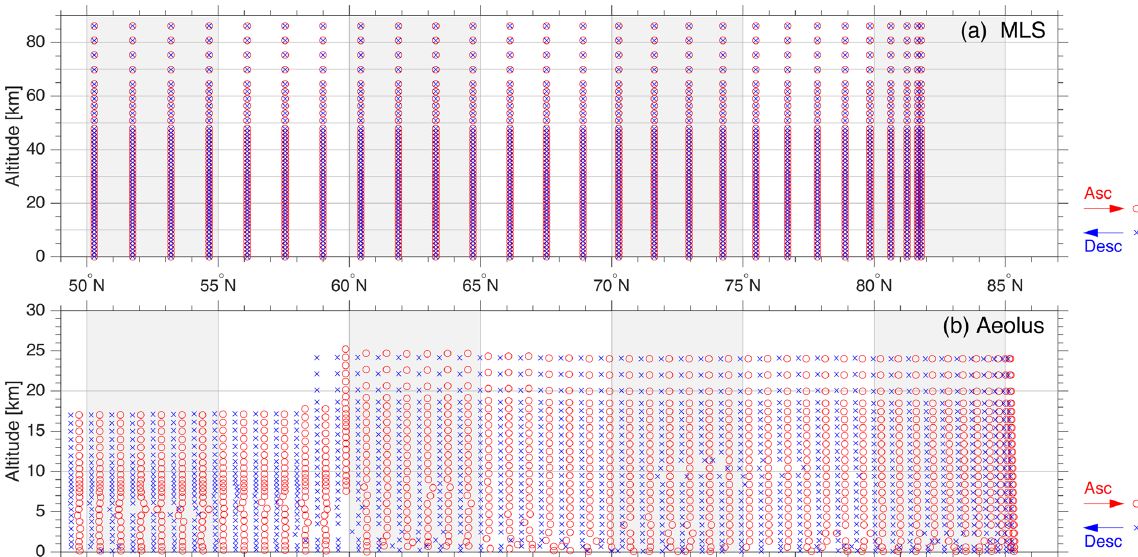
Figure 1. Illustration of (a) MLS and (b) Aeolus measurement spacing in northern polar regions. On each panel, the first complete part-orbit crossing poleward of 60 ◦ N on 5 January 2021 is shown – this orbit is typical for those during our study. Red circles indicate measurements on the latitude-ascending node of the orbit and blue crosses measurements on the latitude-descending node of the orbit. Data are shown on their retrieval grids, which do not inherently correspond to the true resolution of the measurement. Note in particular the sharp change in height coverage at around 60 ◦ N in Aeolus